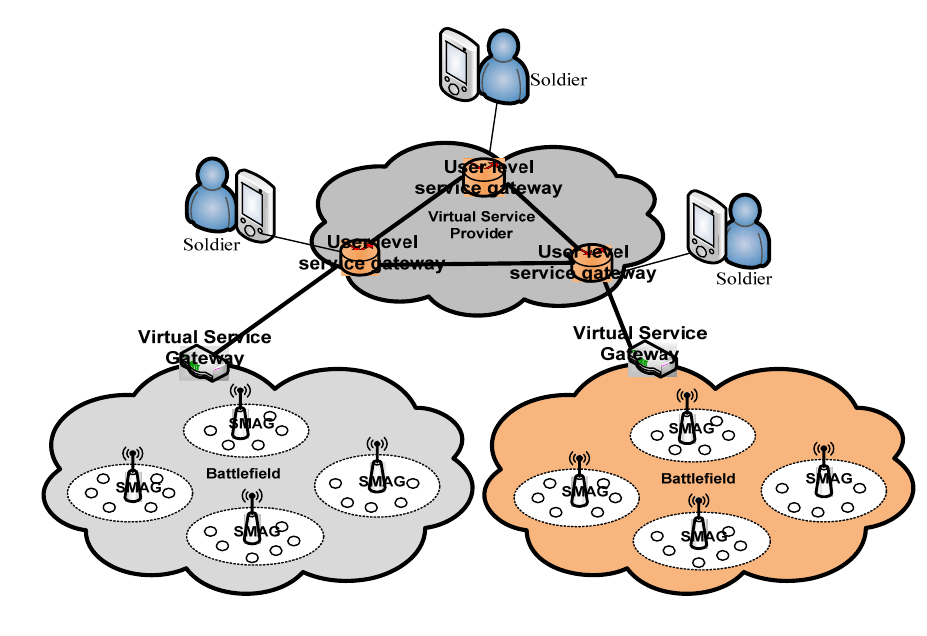
Figure 4. Application of VSNs in battlefield monitoring.